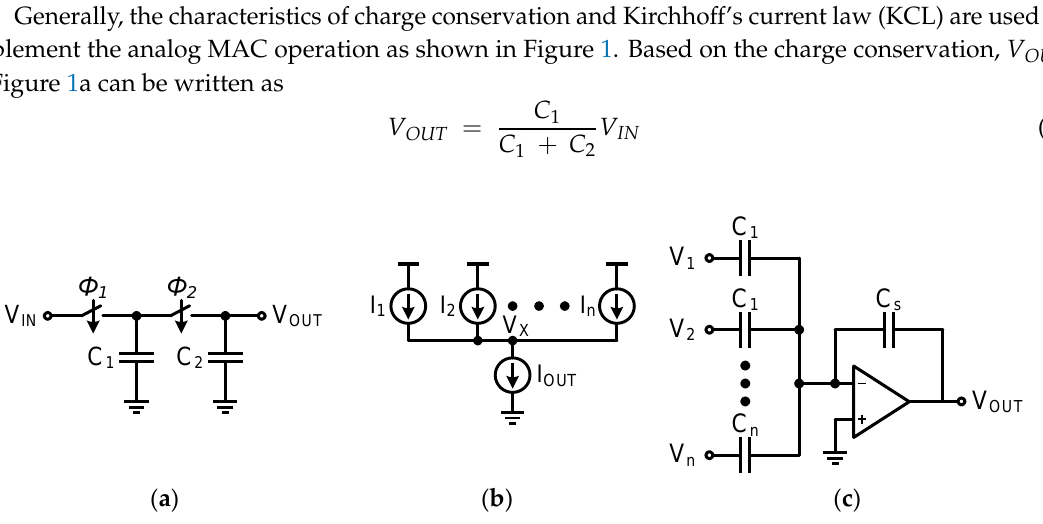
Figure 1. Conventional analog operators: ( a ) analog multiplication using charge conservation, ( b ) analog summation using Kirchhoff’s current law ( KCL) and ( c ) analog multiplication and summation using an operational transconductance amplifier (OTA).